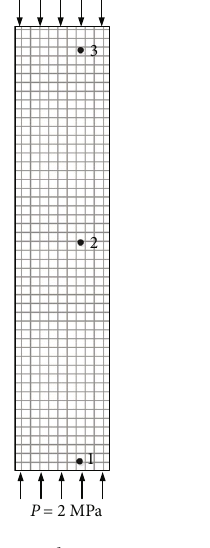
Figure 8: Evolution process in water inrush. Table 2: The value of the main parameters of the